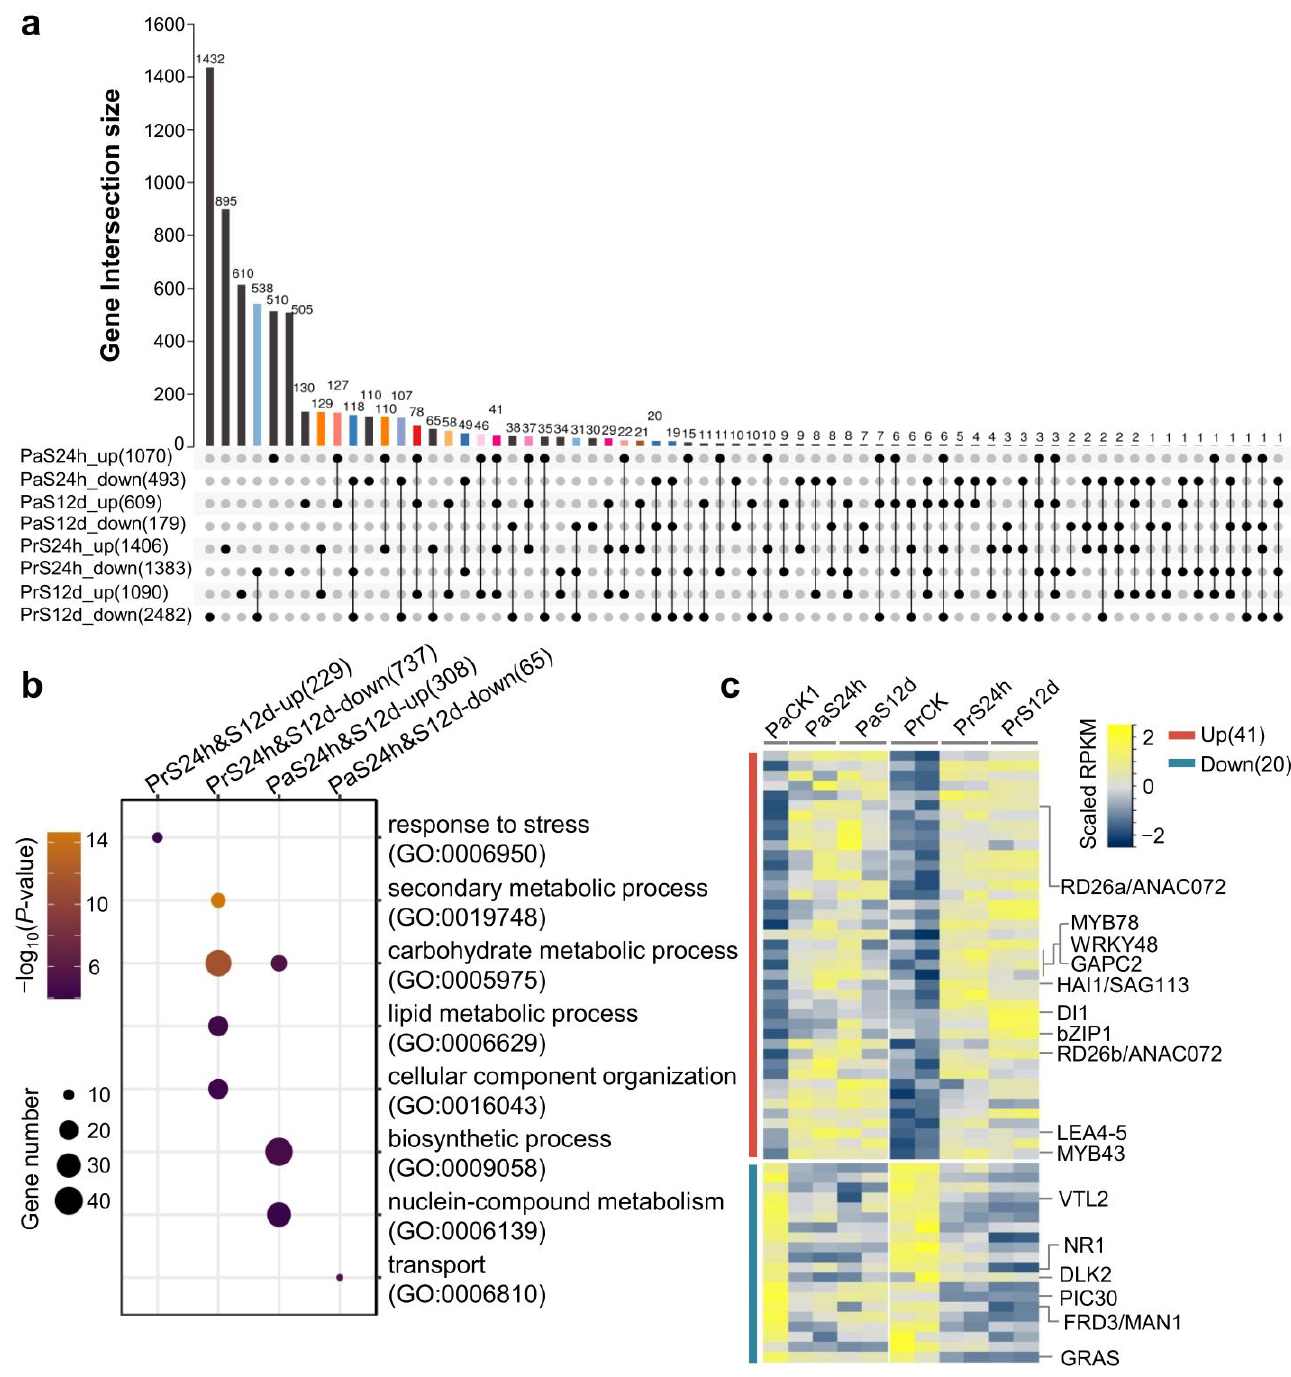
Figure 4. Characteristics of the DEGs identified in P. russkii and P. alba roots under salt stress. ( a ) Upset-plot showing the overlapping genes among the up-regulated and downregulated genes identified in P. russkii and P. alba roots. ( b ) GO enrichment of the overlapping up-regulated or downregulated genes of P. russkii and P. alba roots between short-term and long-term salt stress. ( c ) Heatmap showing the commonly up-regulated or downregulated genes in P. russkii and P. alba roots under salt stress. Two biological replicates are shown except for the control of P. alba .